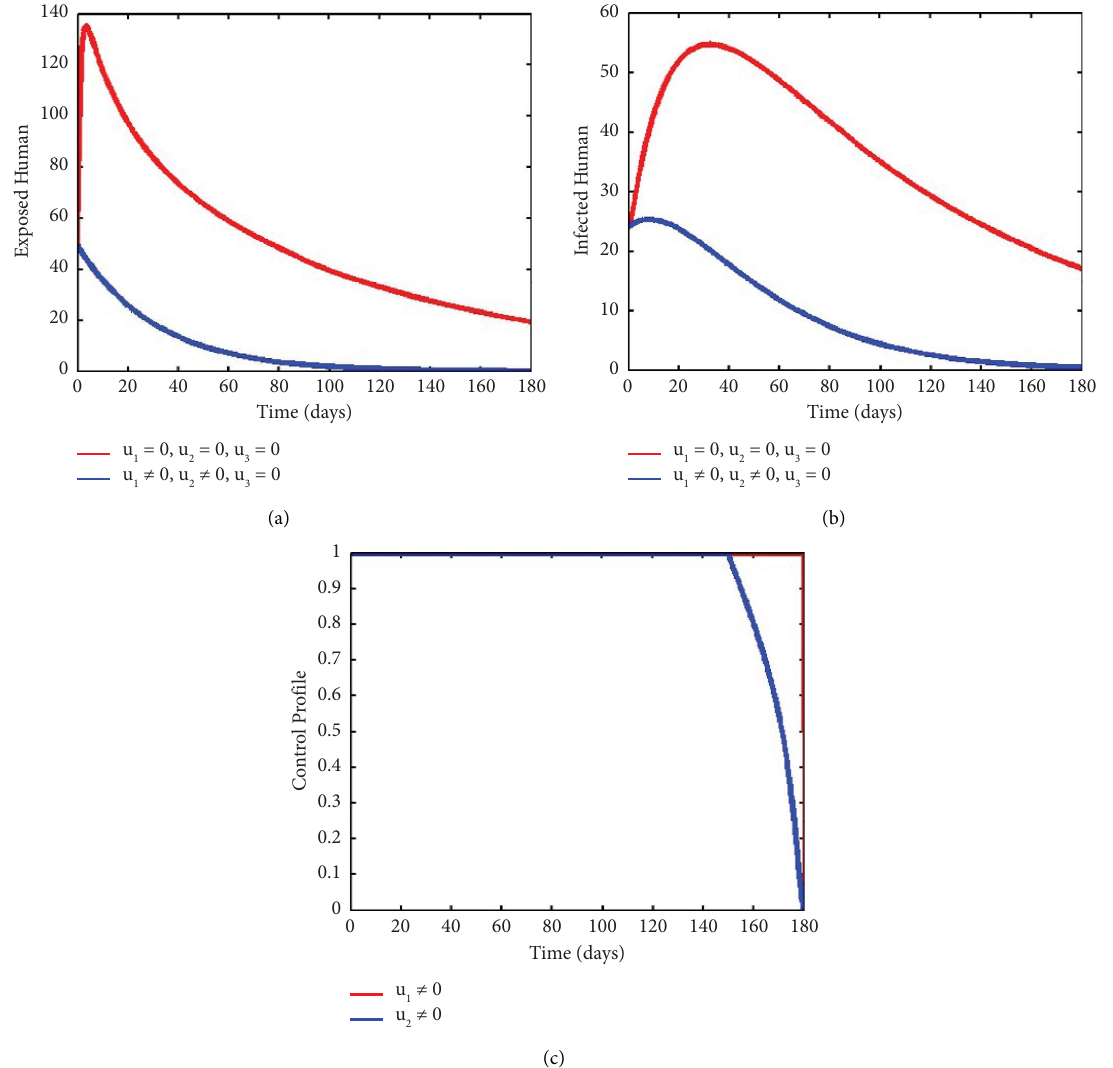
Figure 3: Simulation result with strategy of personal protection u